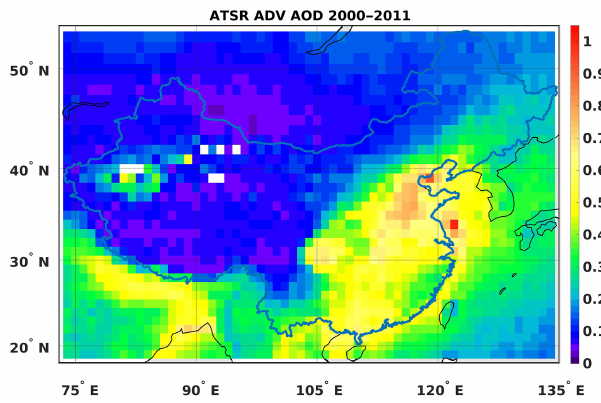
Figure 2. Spatial distribution of the AOD over China, aggregated over the (full) years 2000–2011. The AOD has been retrieved from ATSR-2 and AATSR data, using the ADV v2.31 algorithm. The AOD scale is presented in the color bar to the right of the map. Areas for which no data are available are shown in